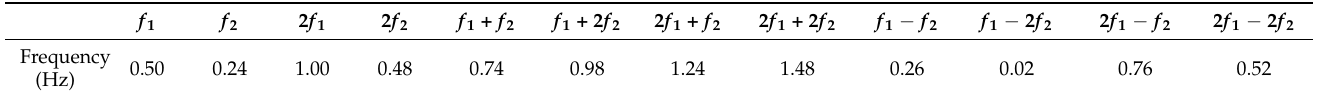
Table 2. Main frequencies of the C1 spectrum analysis under working conditions.